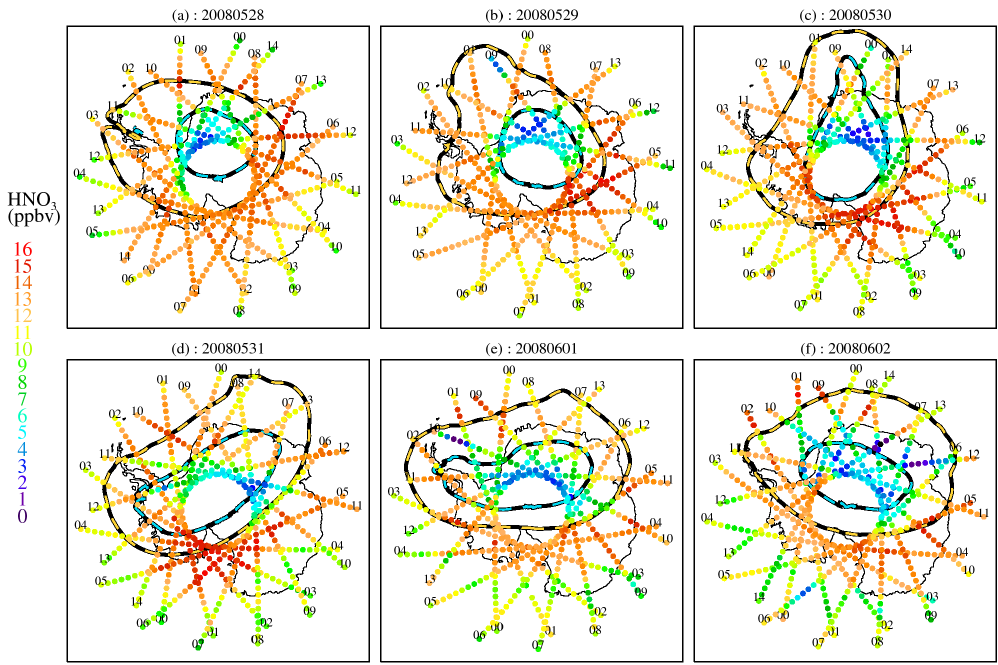
Fig. 13. As Fig. 12, except for MLS HNO 3 at